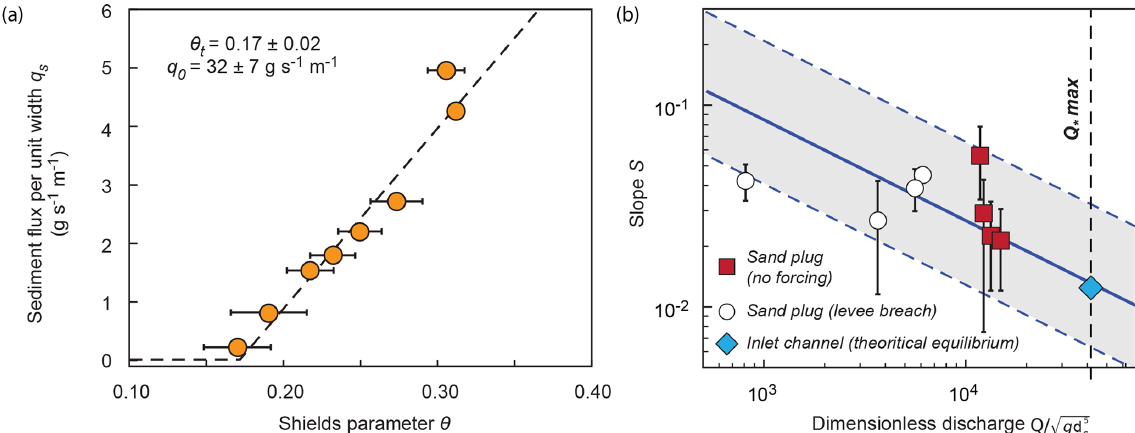
Figure 8. (a) Transport law. Volumetric flux per unit width, as a function of Shield parameter θ . The dashed line corresponds to Eq. (1) fitted to the data. (b) Regime relationship between dimensionless discharge Q ∗ and slope measured in the experiments. The solid blue line corresponds to the threshold theory (Eq. 2, θ t = 0 . 17 and C f = 0 . 06). The shaded area and dashed lines indicate uncertainty based on varying friction coefficient C f